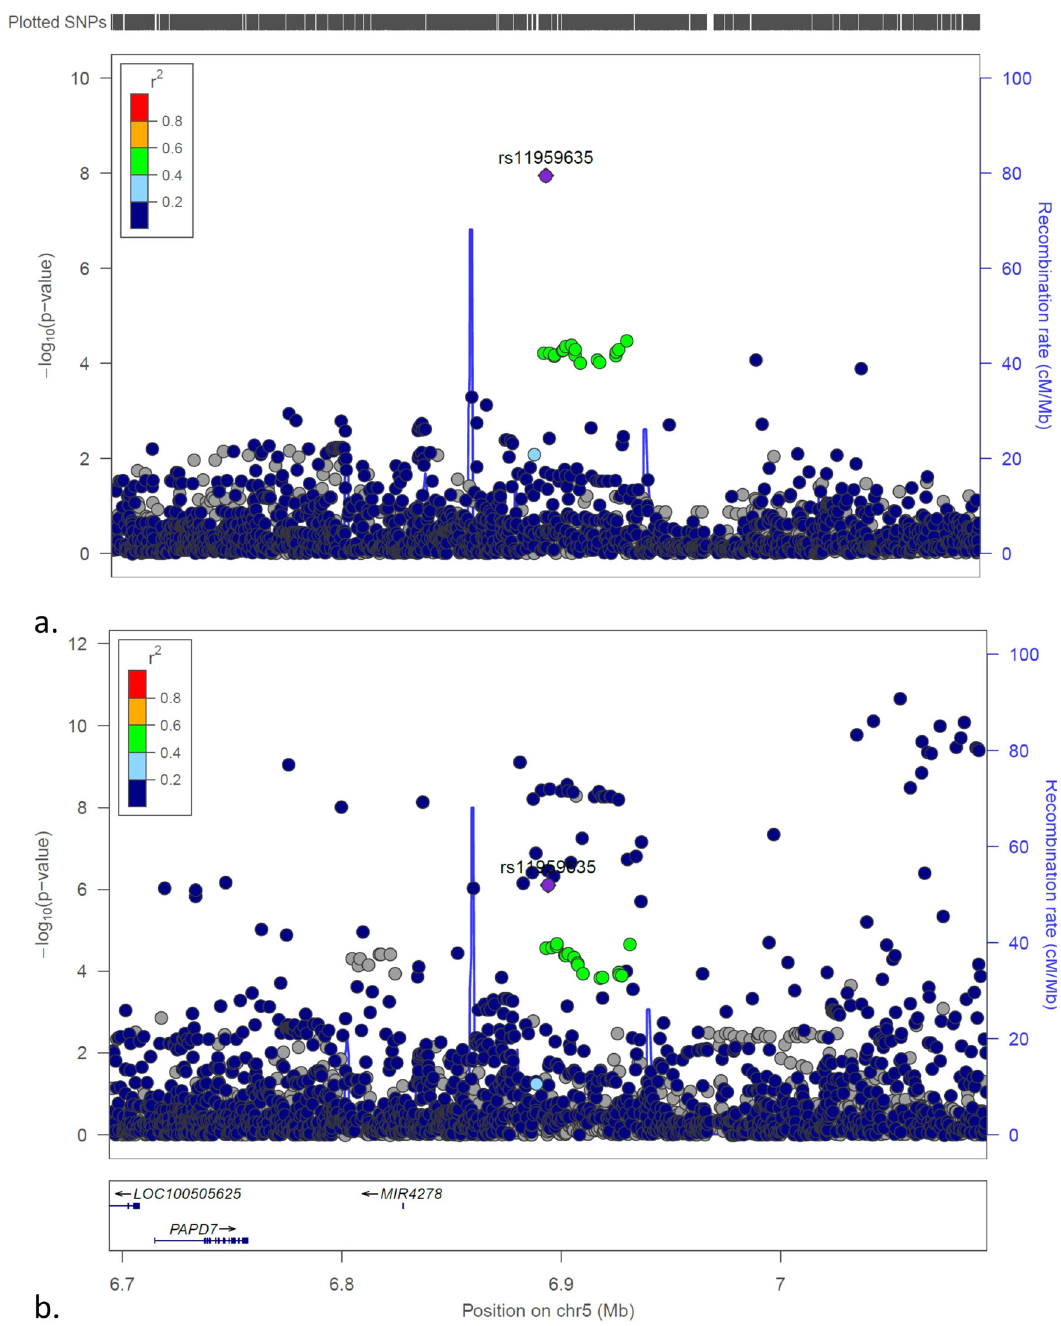
Fig. 4 The LocusZoom plots for the MIR4278;MIR4454 locus. a The plot of the association tests of T1D patients with low T1D GRS compared to controls; ( b ) The plot of the association tests of all T1D patients compared to